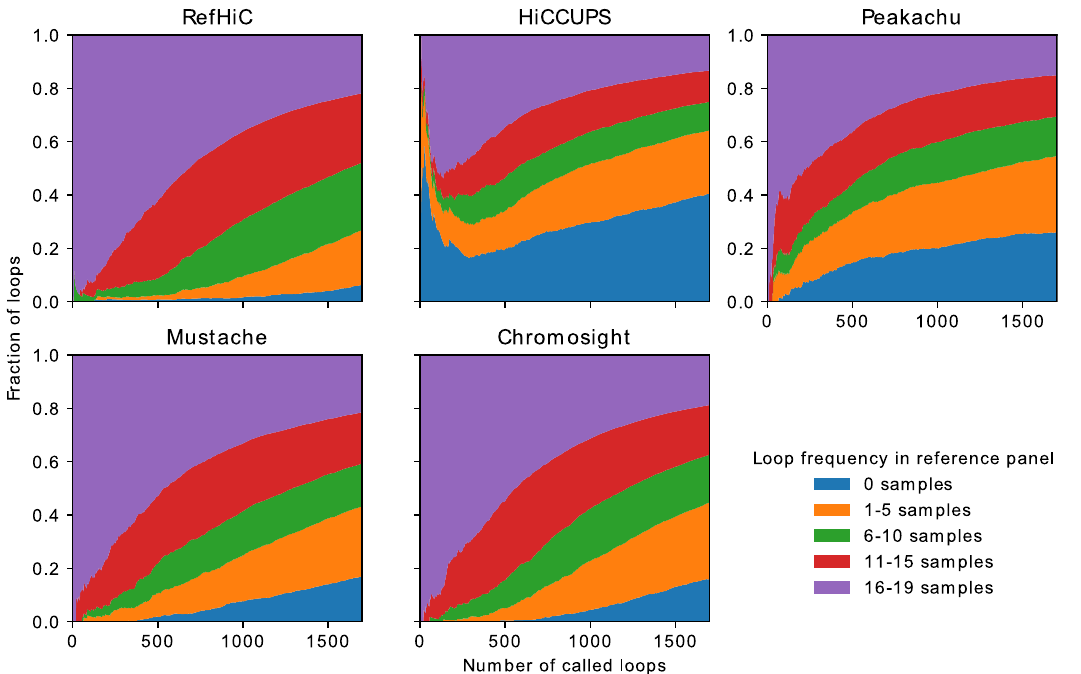
Fig. 5| Comparisonof tools ’ ability toidentifyrare and common loops. Loop frequencywithinthe referencepanelisassessed based on Mustache and Chromosight ’ s predictions on individual reference Hi-C data